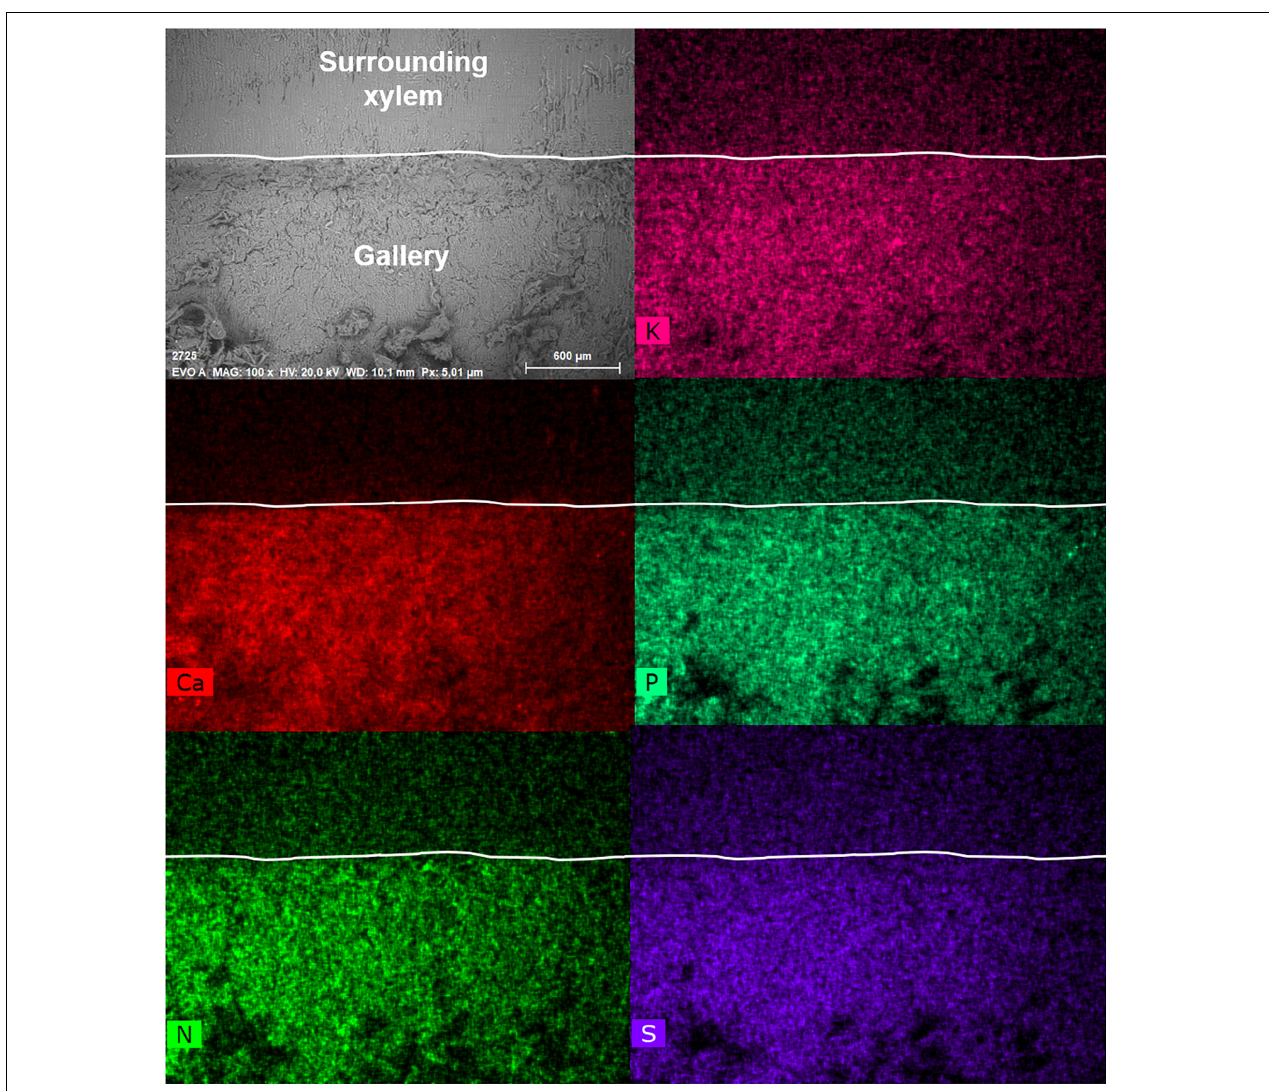
FIGURE 4 | Visualization of elements within a gallery of Trypodendron lineatum (ID = T.lin9) using the mapping function of the SEM-EDX. The SEM image on the top left (EVO A) shows the inside of the gallery (bottom) and the surrounding xylem (top, starting from the ridge). The border from gallery to surrounding xylem was indicated with a white line in each image. Scale bar and magnification (100 × ) are given at the bottom of the image. The intensity of the colors in the other images reflect the abundance of the elements potassium (K), calcium (Ca), phosphorus (S), nitrogen (N), and sulfur